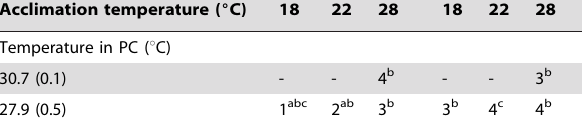
Figure 4. Fish distribution over the preference chamber. Fish distributions during non-gradient, acute preference and 24 h preference observations are expressed as odds ratios (proportion of temperature zones used dived by the proportion of temperature zones available) and are presented for fish acclimated to 18 u C (A), 22 u C (B) and 28 u C (C). Fish distribution was non-random during all non-gradient observations (MANOVA, p=0.002) without differences among temperature acclimation treatments (MANOVA, p=0.42). Fish distribution observed during acute preference observations differed significantly from the non-gradient observations (MANOVA, p , 0.001). Fish distribution during 24 h preference observations differed significantly from the non-gradient (MANOVA, p , 0.0001) as well as the acute preference observations (MANOVA, p , 0.002). Among acclimation temperature treatments fish distribution differed during acute preference observations (MANOVA, p=0.01) but not during the 24 h preference observations (MANOVA, p=0.21).